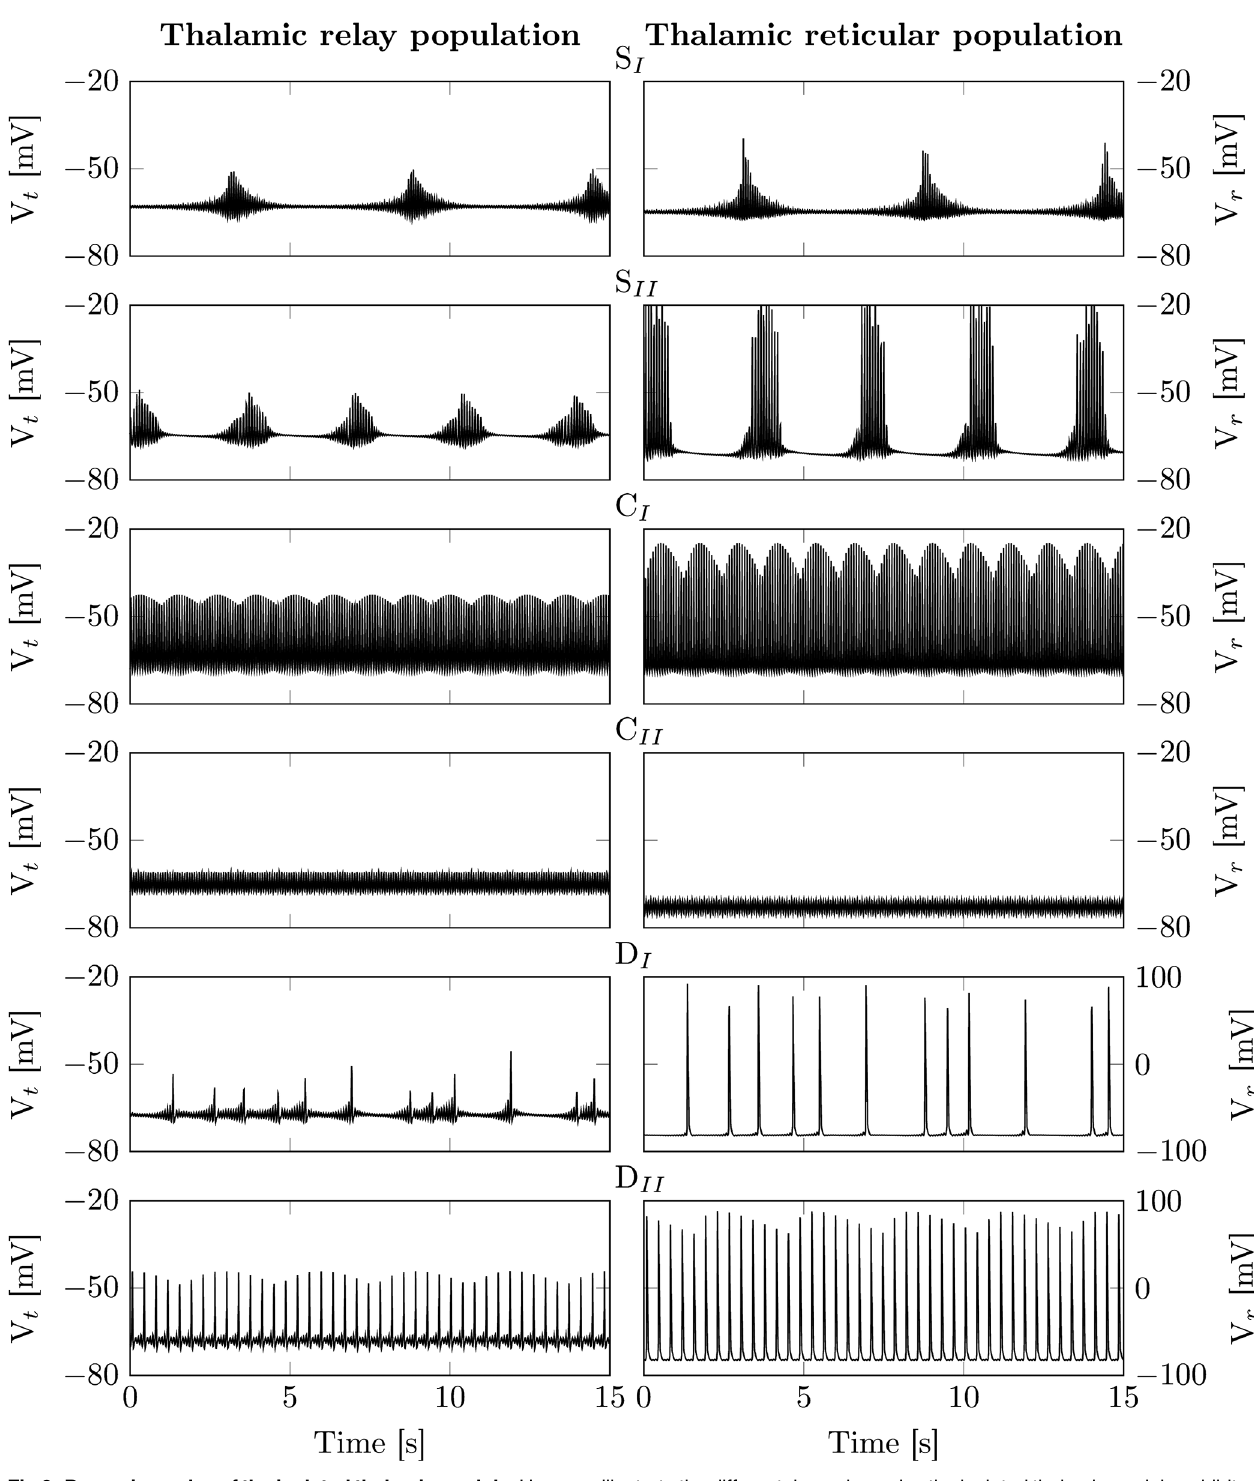
Fig 3. Dynamic modes of the isolated thalamic module. Here, we illustrate the different dynamic modes the isolated thalamic module exhibits. The left panels depict the thalamic relay membrane voltage, whereas the right panels illustrate that of the thalamic reticular population. The parameter values are depicted in Fig 2 and given in Table 1. S I and S II : The isolated thalamus generates rhythmic spindle oscillations via a balanced interplay between I T and I h . The length and the average time between spindles is governed by (cid:2) g regime fast oscillations generated by the T-type calcium currents dominate and I h is unable to suf fi ciently depolarize the thalamic relay population to cease them. D I and D II : For strong hyperpolarization through I LK the thalamic module switches into low frequency delta oscillations.